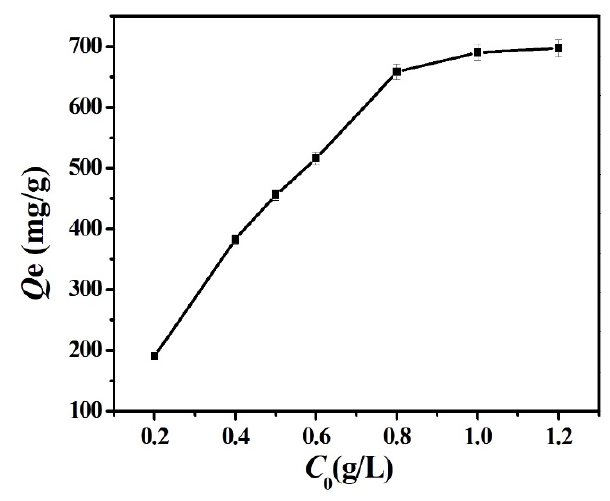
Figure 10. Effect of initial lysozyme concentration on adsorption capacity.